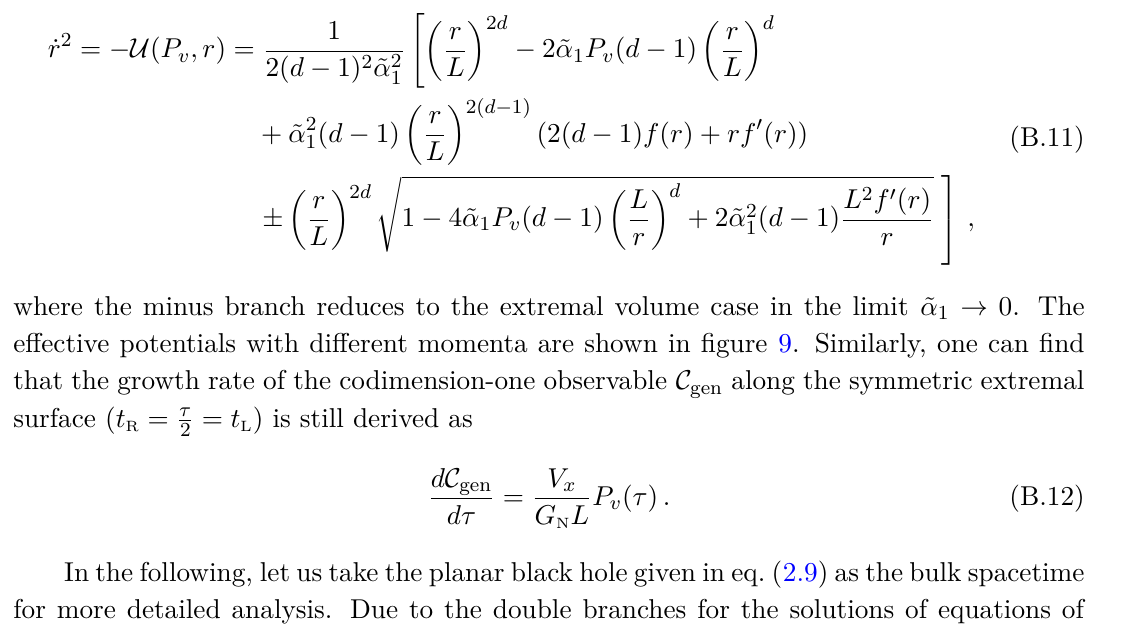
= α /L . Thanks to the independence of v ( λ ) , 1 1